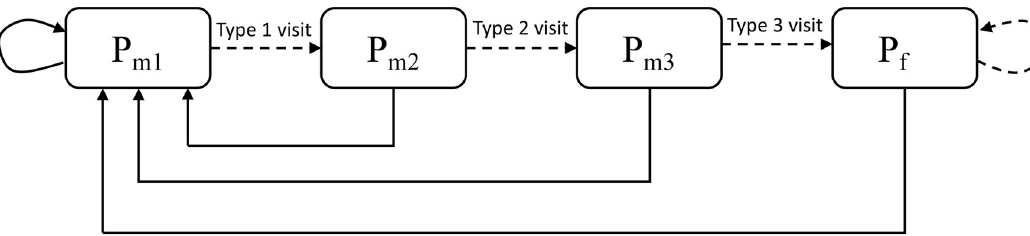
Fig 2. Model flow diagram of pollinator types. Solid lines depict visits to a male flower. Dashed lines depict visits to a female flower.